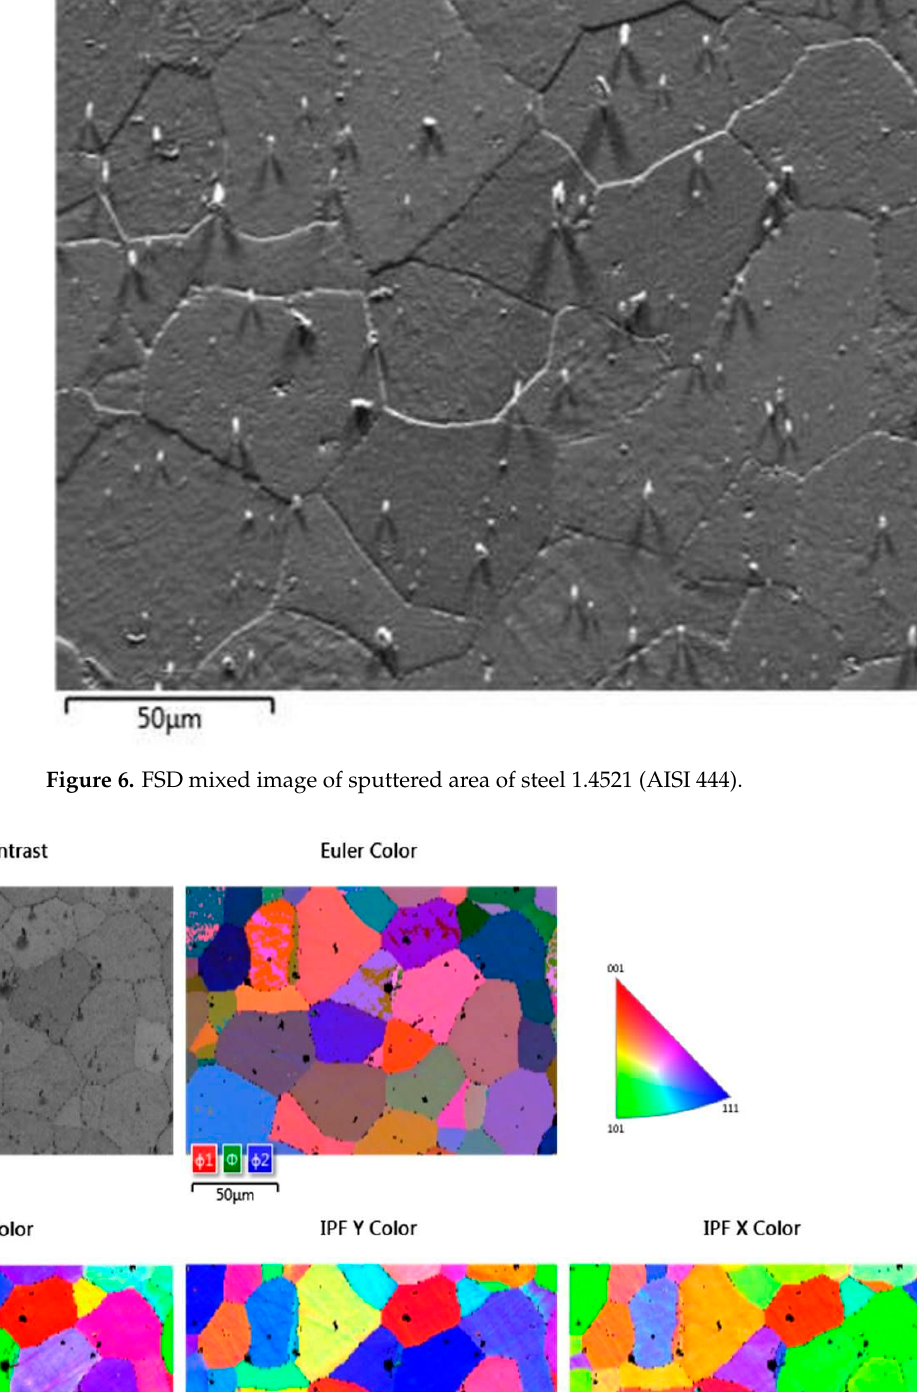
Figure 8. FSD mixed image of sputtered area of steel 1.4521 (AISI 444).